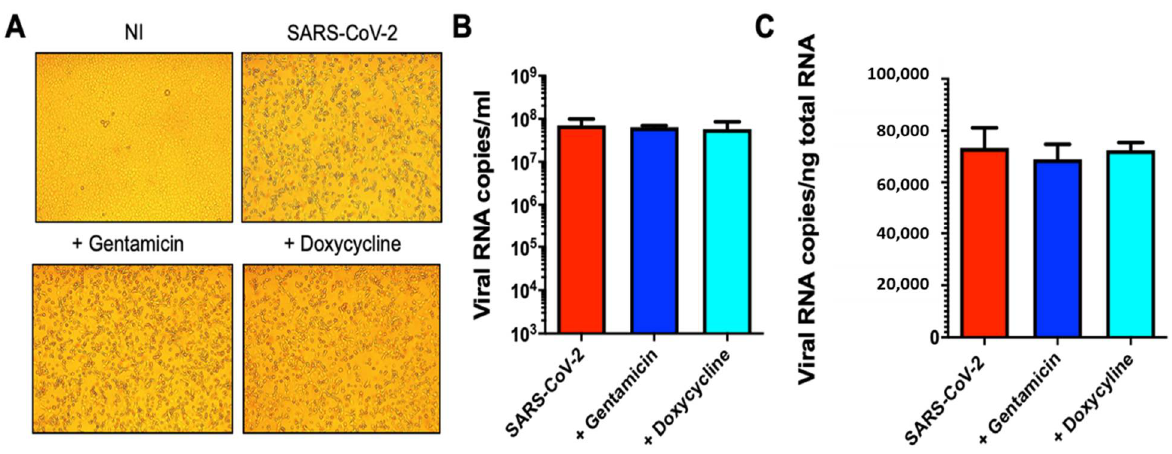
Figure 3. Doxycycline did not inhibit SARS-CoV-2 authentic virus replication. Vero E6 cells were pretreated for 4 h with doxycycline or gentamicin (100 μM), then infected with SARS-CoV-2 at a multiplicity of infection (MOI) of 0.01 for 1 h at 37 °C with doxycycline or gentamicin (100 μM). Cells were then washed and cultured for 48 h in fresh medium containing doxycycline or gentamicin (100 μM). Non-infected cells (NI) or cells infected without doxycycline or gentamicin treatment (SARS-CoV-2) were used as controls. ( A ) Cells were imaged with an optical microscope to detect typical SARS-CoV-2- induced cytolytic effects (original magnification 10×). ( B ) Viral yield was quantified in the cell supernatant by qRT-PCR. ( C ) Quantification of SARS-CoV-2 genomes at the intracellular level by qRT-PCR. Data are means ± SD of at least three independent replicates.